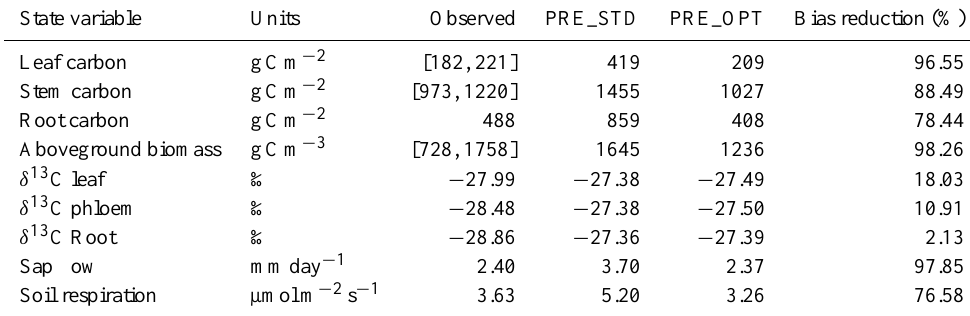
Table 2. Pretreatment state variables included in the optimization. Simulated values were obtained using the default parameters (PRE_STD) and the optimized parameters (PRE_OPT). The bias reduction (%) caused by the optimization is listed in the last column. In the case of leaf, root, and aboveground biomass, we use allometric equations from multiple sources (Baldwin and Feduccia, 1987; Naidu et al., 1998; Vanlear et al., 1986) that went into producing a range. The bias calculation uses the mean of the range. For sap flow and soil respiration, daily observations were made, but the values represent a mean over the 25 pretreatment days over both LS and HS periods. δ 13 C values represent observed and simulated values on the day before treatments